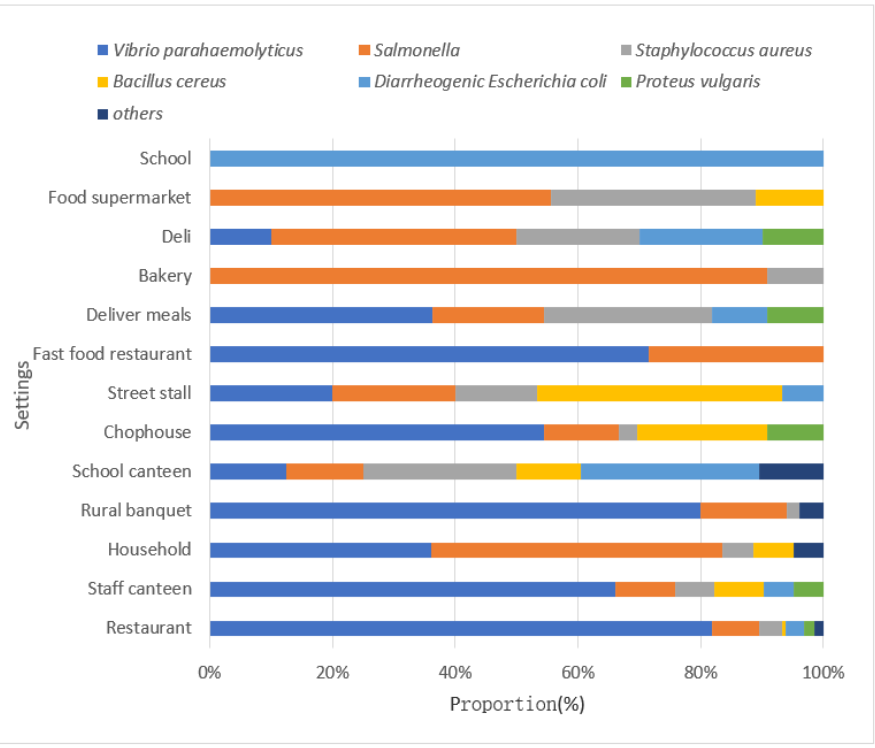
Figure 3. Setting-etiology distribution of outbreaks of bacterial FBDOs in Zhejiang Province, 2010–